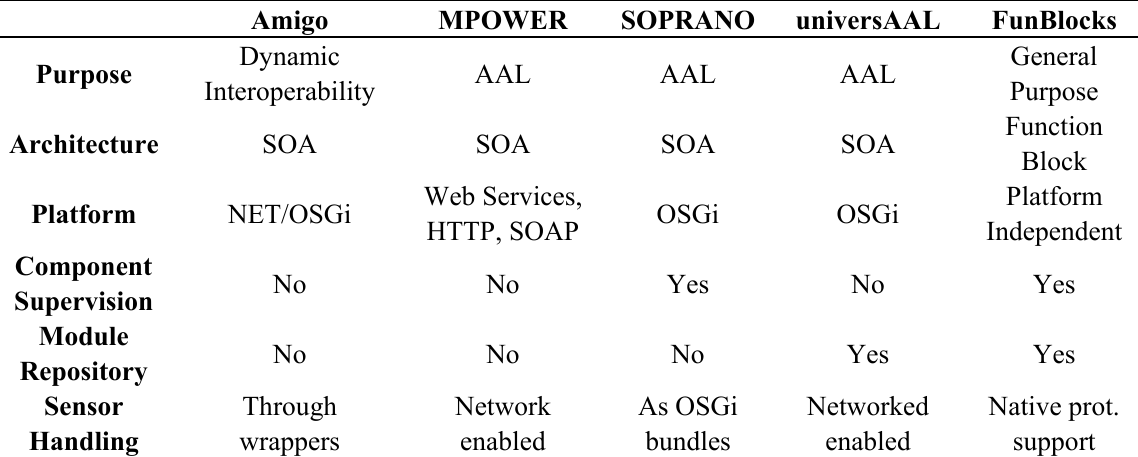
Table 1. Framework